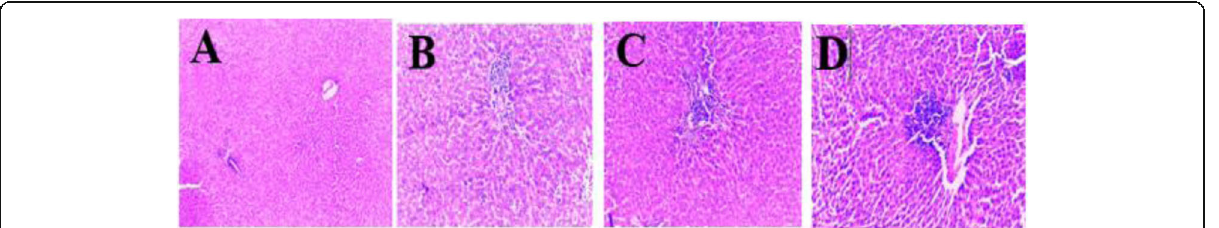
Fig. 1 a - d Shows photomicrographs of liver tissue of rats. a (control): A cross section of the liver in control rat with the arrows showing the hepatocyte sinusoid and the portal tract having normal histological appearance (×100 magnification). All sections were stained with haematoxylin and eosin. b A cross section of the liver of rats treated with 250 mg/kg of the ethanol extract of H. madagascariensis lam . Showing mild inflammatory changes (×200 magnification). All section stained with hematoxylin and eosin. c A cross section of the liver in rat treated with 500 mg/kg of ethanol extract of H. mdagascariensis with arrow showing inflammations of the periportal tract (×200 magnification). All section stained with haematoxylin and eosin. d A cross section of liver in rat treated with 1000 mg/kg of ethanol extract of H. madagascariensis lam. With arrow showing marked periportal inflammation (× 200 magnification). All section stained with haematoxylin and eosin